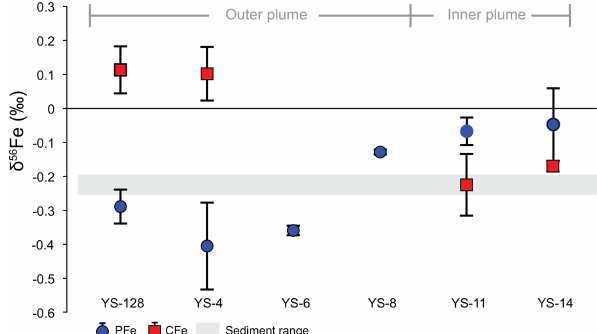
Figure 6. Iron-isotope values along the Lena River freshwater plume and the uppermost sediment of the East Siberian Arctic Shelf (ESAS). The error bars represent ± 2 σ . In some cases the symbol is larger than the error. The δ 56 Fe values of PFe are negative at all stations: values close to zero are closer to the coast and more neg- ative ones are towards the open sea. The δ 56 Fe values of the CFe are negative in the inner plume and positive in the outer plume. The δ 56 Fe of the sediment samples were around − 0 . 2‰, displaying the overall composition of the entire ESAS